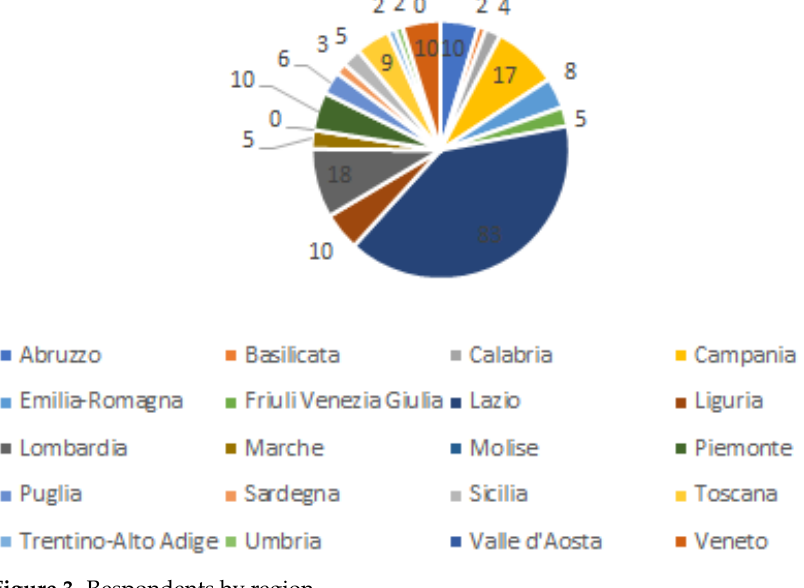
Figure 3. Respondents by region.